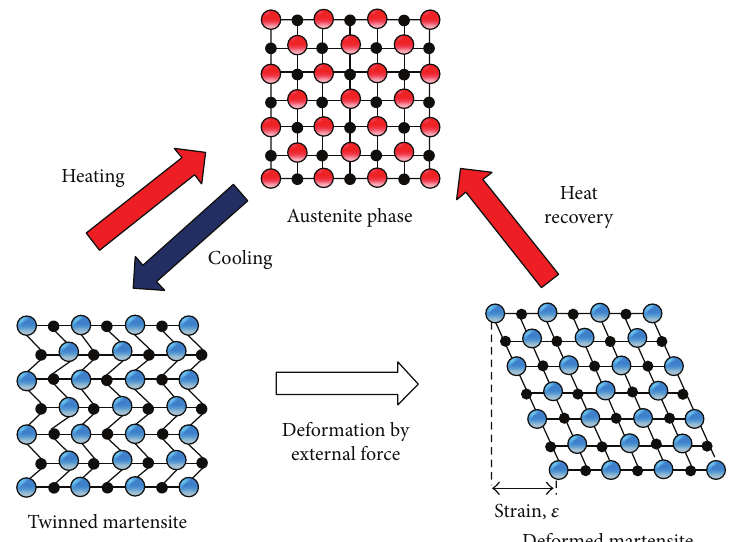
Figure 1: SMA phases and crystal